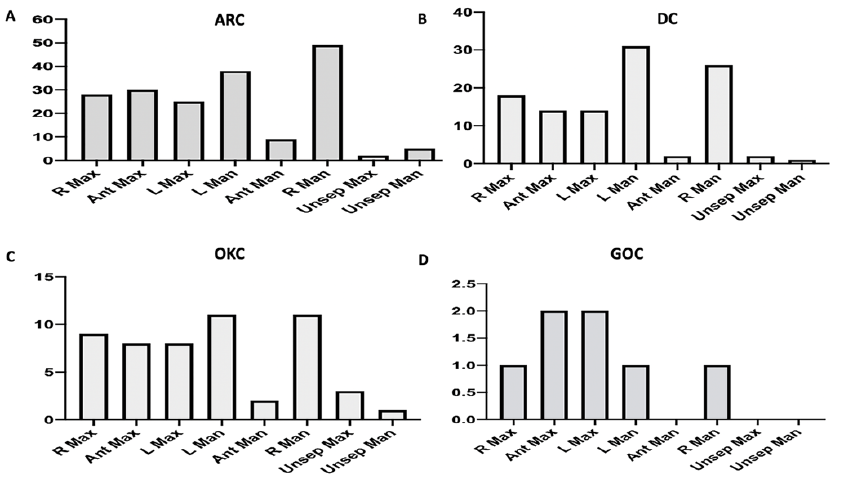
Figure 5. Distribution of OCs according to the specific location. ( A ) ARC, ( B ) DC, ( C ) OKC, ( D ) GOC. (Abbreviations: R Max, right maxilla; Ant Max, anterior maxilla; L Max, left maxilla; L Man, left mandible; Ant Man, Anterior mandible; R Man, right mandible; Unsep Max, unspecified location in maxilla; Unsep Man, unspecified location in mandible.